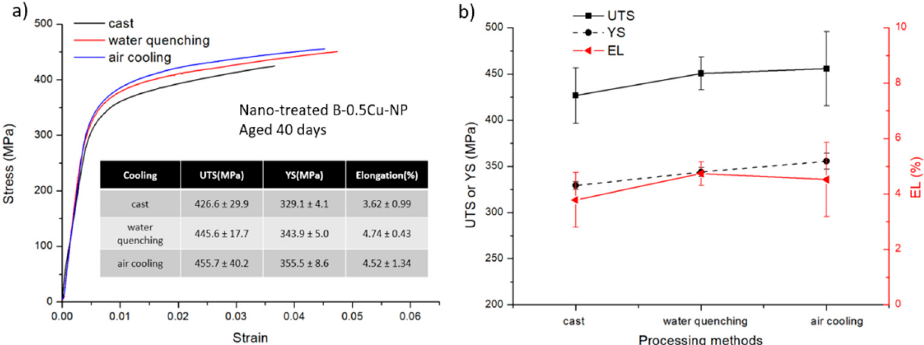
Figure 6. ( a ) Tensile testing of the nano-treated B-0.5Cu-NP samples aging for 40 days after casting, water quenching, and air cooling. The inserted table contains tensile data. ( b ) Comparison of the corresponding UTS, YS, and EL values of each sample